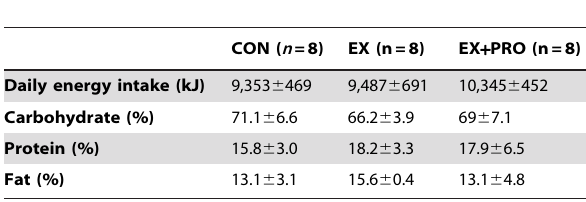
Groups as per Table 1. Values are presented as means 6 SEM. doi:10.1371/journal.pone.0020613.t002 PLoS ONE |